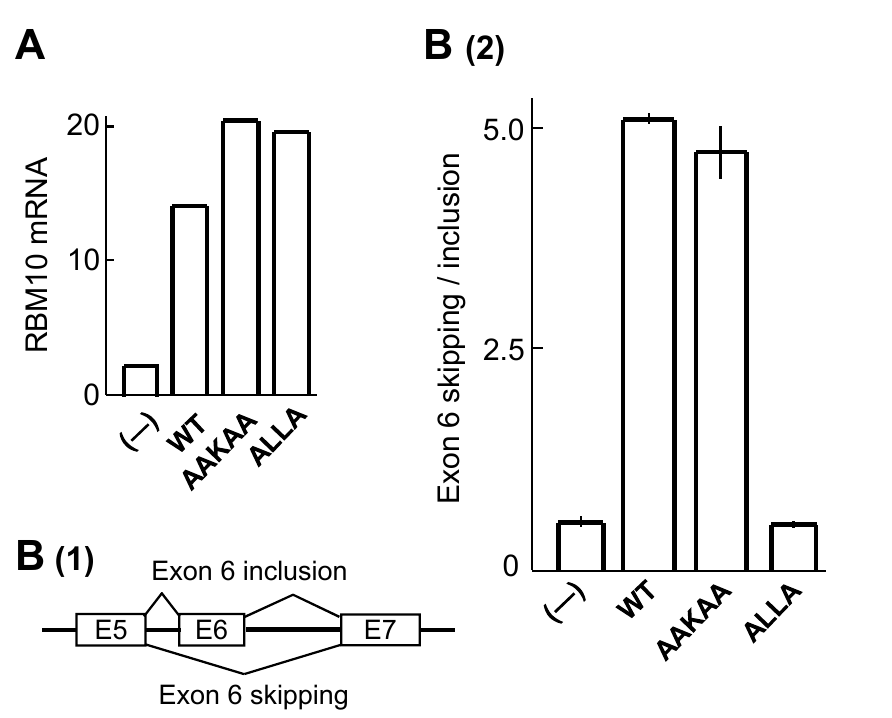
Figure 6. NBTS2/C 2 H 2 ZnF is essential for regulation of AS by RBM10 . RBM10-knockout HepG2 cells were transduced with lentivirus carrying wild-type RBM10 or RBM10 in which the KEKKE sequence in NBTS1 was mutated to AAKAA or the CLLC sequence in NBTS2 was mutated to ALLA. After 3 days, expression levels of mRNAs and fas transcripts were examined. ( A ) mRNA expression levels of RBM10 and its mutants. (–) WT, AAKAA, and ALLA indicate the RBM10-knockout HepG2 cells and those transduced with wild-type RBM10 or RBM10 with the mutation of AAKAA or ALLA, respectively. ( B ) (1) AS of fas pre-mRNA: Skipping and inclusion of exon 6. (2) Skipping/inclusion ratios of exon 6. The results of two separate experiments were averaged, with deviations indicated by vertical lines at the tops of the bars. Two independent experiments yielded similar results, as seen in the small deviations of the averaged exon 6-skipping/inclusion values. However, RBM10 mRNA expression levels in one experiment were roughly 50% lower than those in A (data not shown), suggesting that the expressed construct proteins in both experiments were at saturation levels in performing the AS of fas